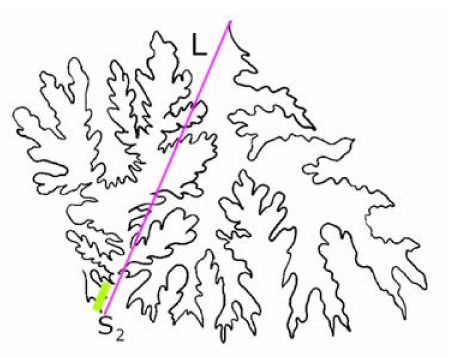
Figure 3. A lateral lobe–saddle pair of Lytoceras taharoaense , the rule size (green) is one-tenth the distance L max (magenta) from the base of the lateral lobe (L) to that of S 2 . Redrawn by KM from Figure 23 in [33].